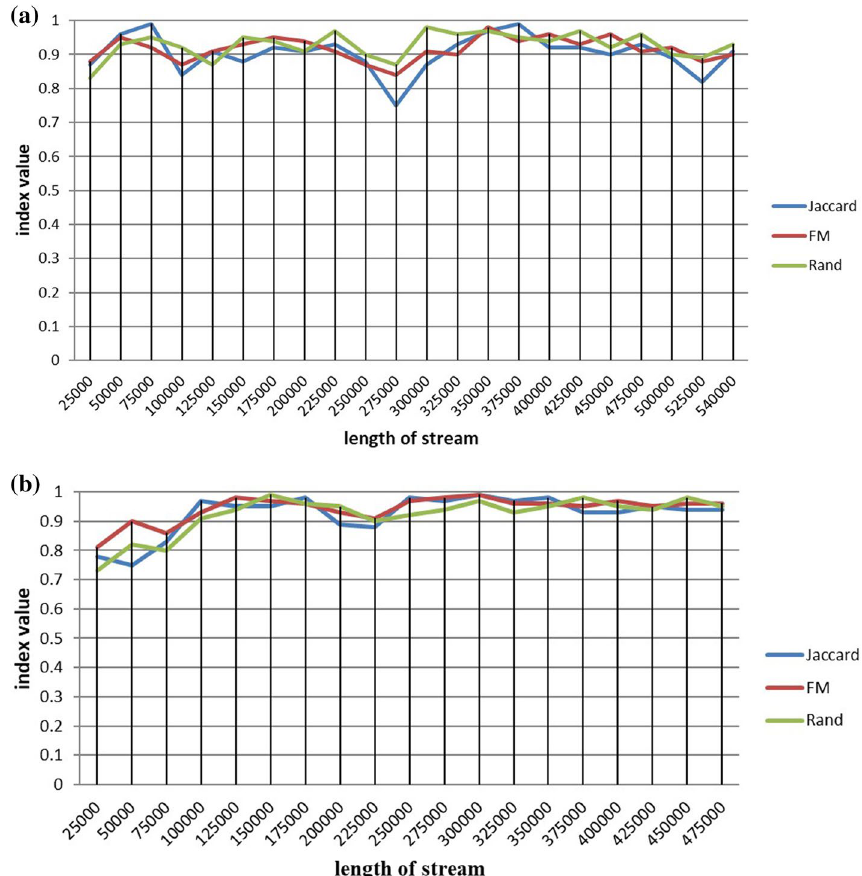
Fig. 16 Reference model: EDMStream. In the figure 16, the blue, red and green fold were respectively used to record Jaccard, FM and Rand indicators when reference model is EDMStream. A shows cluster quality in CoverType and B shows cluster quality in